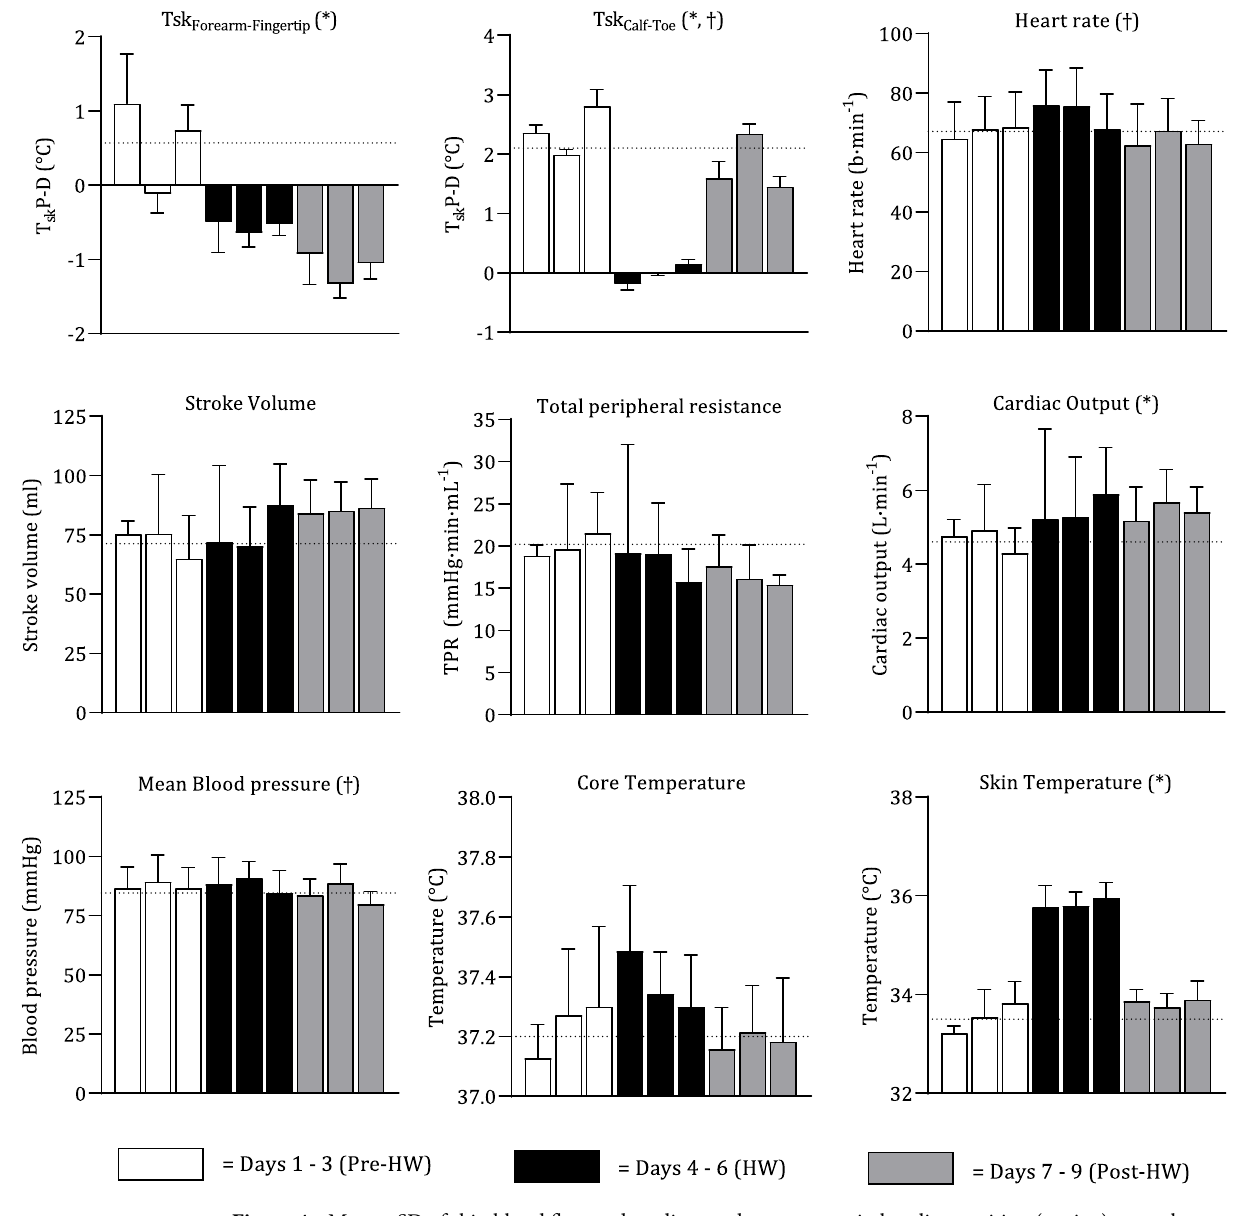
Figure 4. Mean ± SD of skin blood flow and cardiovascular responses in baseline position (supine) on each individual day. White bars indicate pre-HW (days 1–3), black bars indicate HW (days 4–6), and grey bars indicate post-HW (days 7–9). Dotted line displays the average value of the pre-HW period. † indicates a significant difference between pre-HW and post-HW, * indicates a significant correlation between pre-HW and